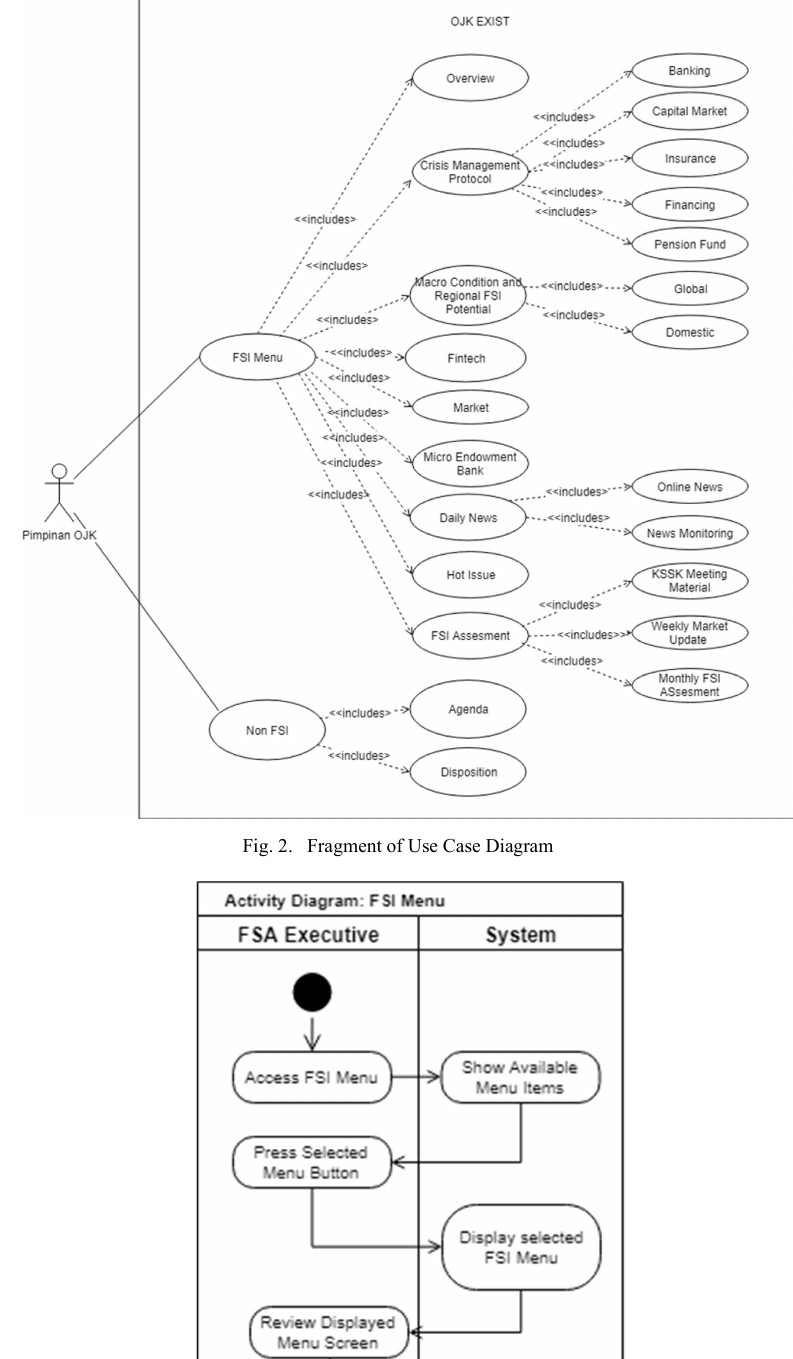
Fig. 3. Fragment of Activiy